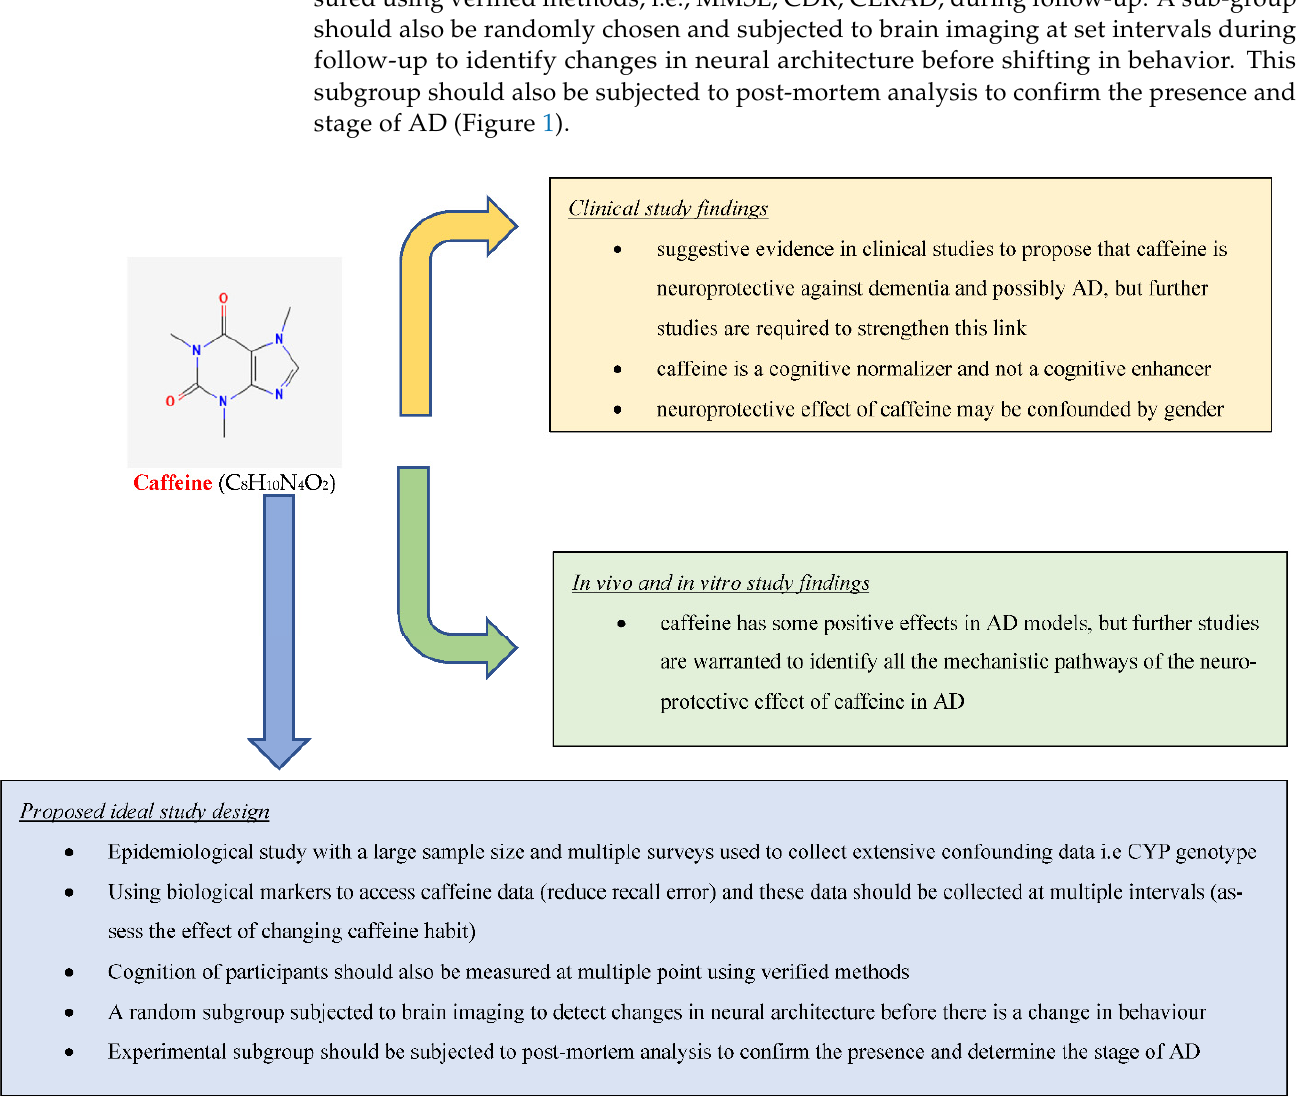
Figure 1. Summary of findings.